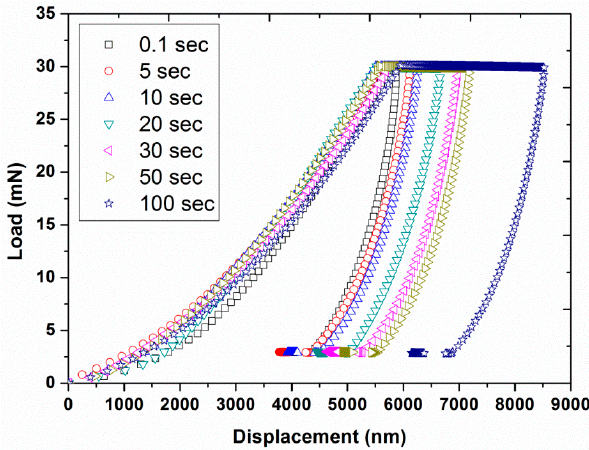
Figure 13. Indentation load as a function of displacement by having a peak load of 30 mN for various holding times (0.1, 5, 10, 20, 30, 50, and 100 s) with loading time of 10 s.